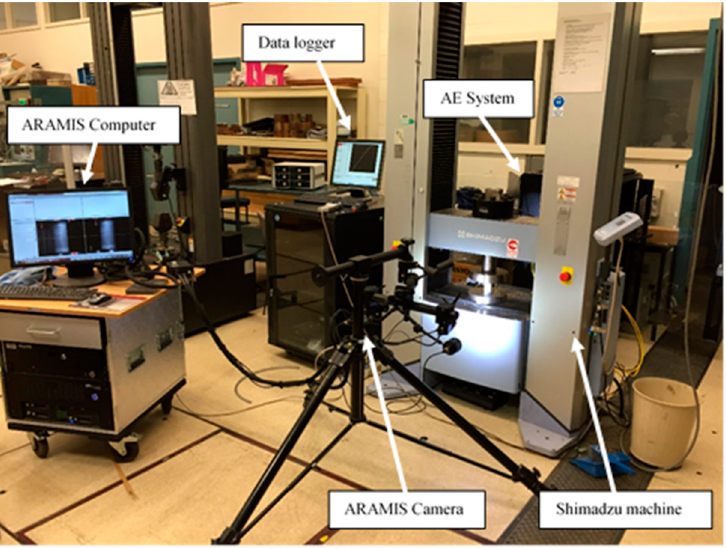
Figure 2. Shimadzu testing machine with ARAMIS (non-contact and material independent measuring system) and acoustic emission (AE) system. system) and acoustic emission (AE)